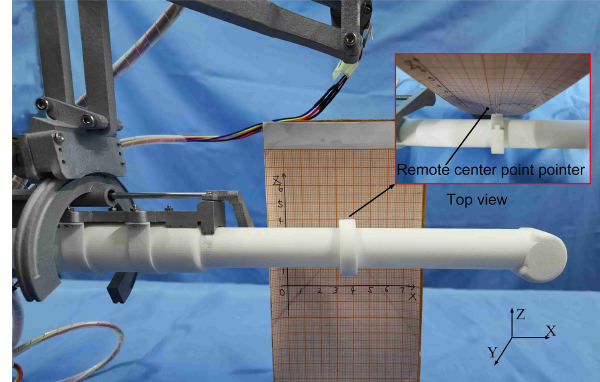
Figure 15. The measurement experiment of the pitch angle’s re- mote center